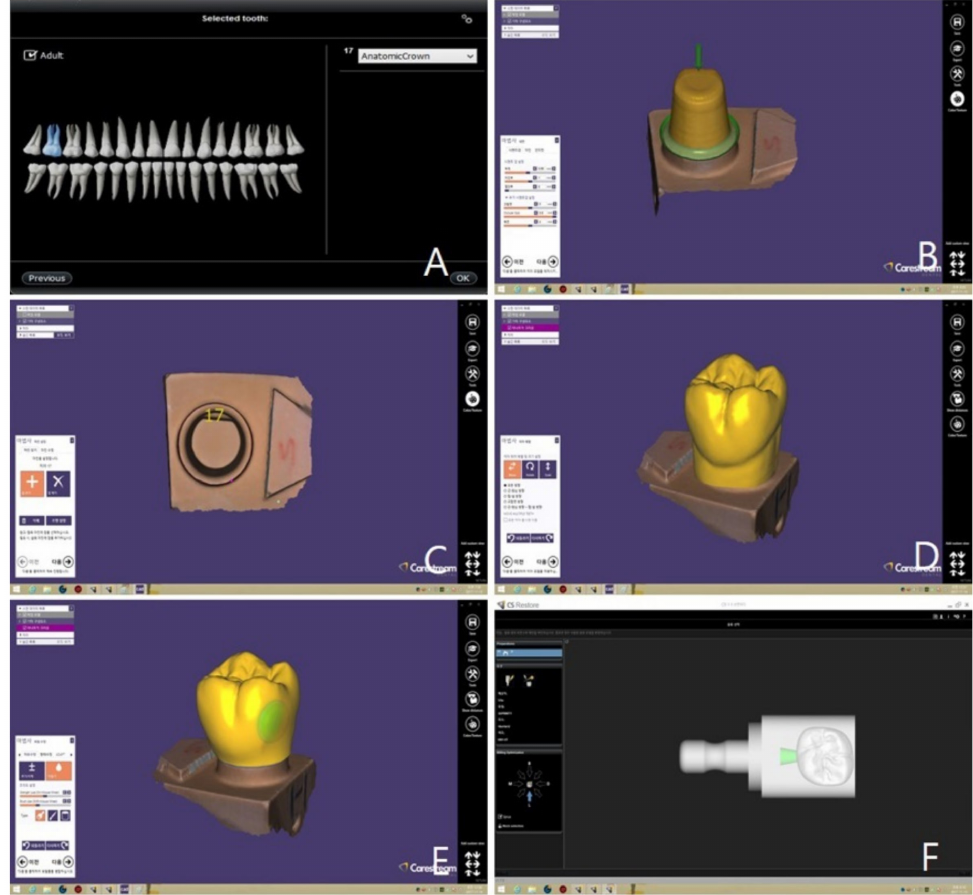
Figure 3. Crown design process using computer-aided design and manufacturing software with the Carestream system. ( A ) Selection of teeth to be restored; ( B ) numerical values as parameters ( C ) design of margins and insertion axes; ( D ) crown selection from the proposed library; ( E ) crown modeling; ( F ) crown alignment for